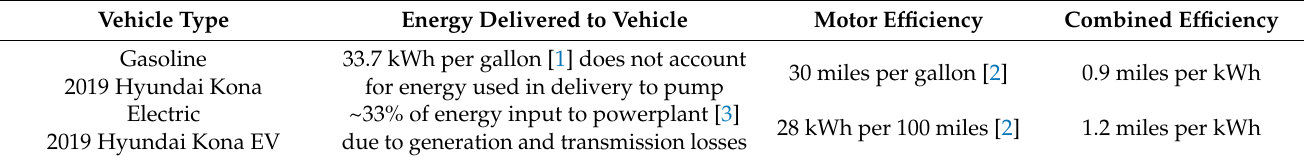
Table 1. Gasoline vehicle and EV miles traveled per unit of energy.